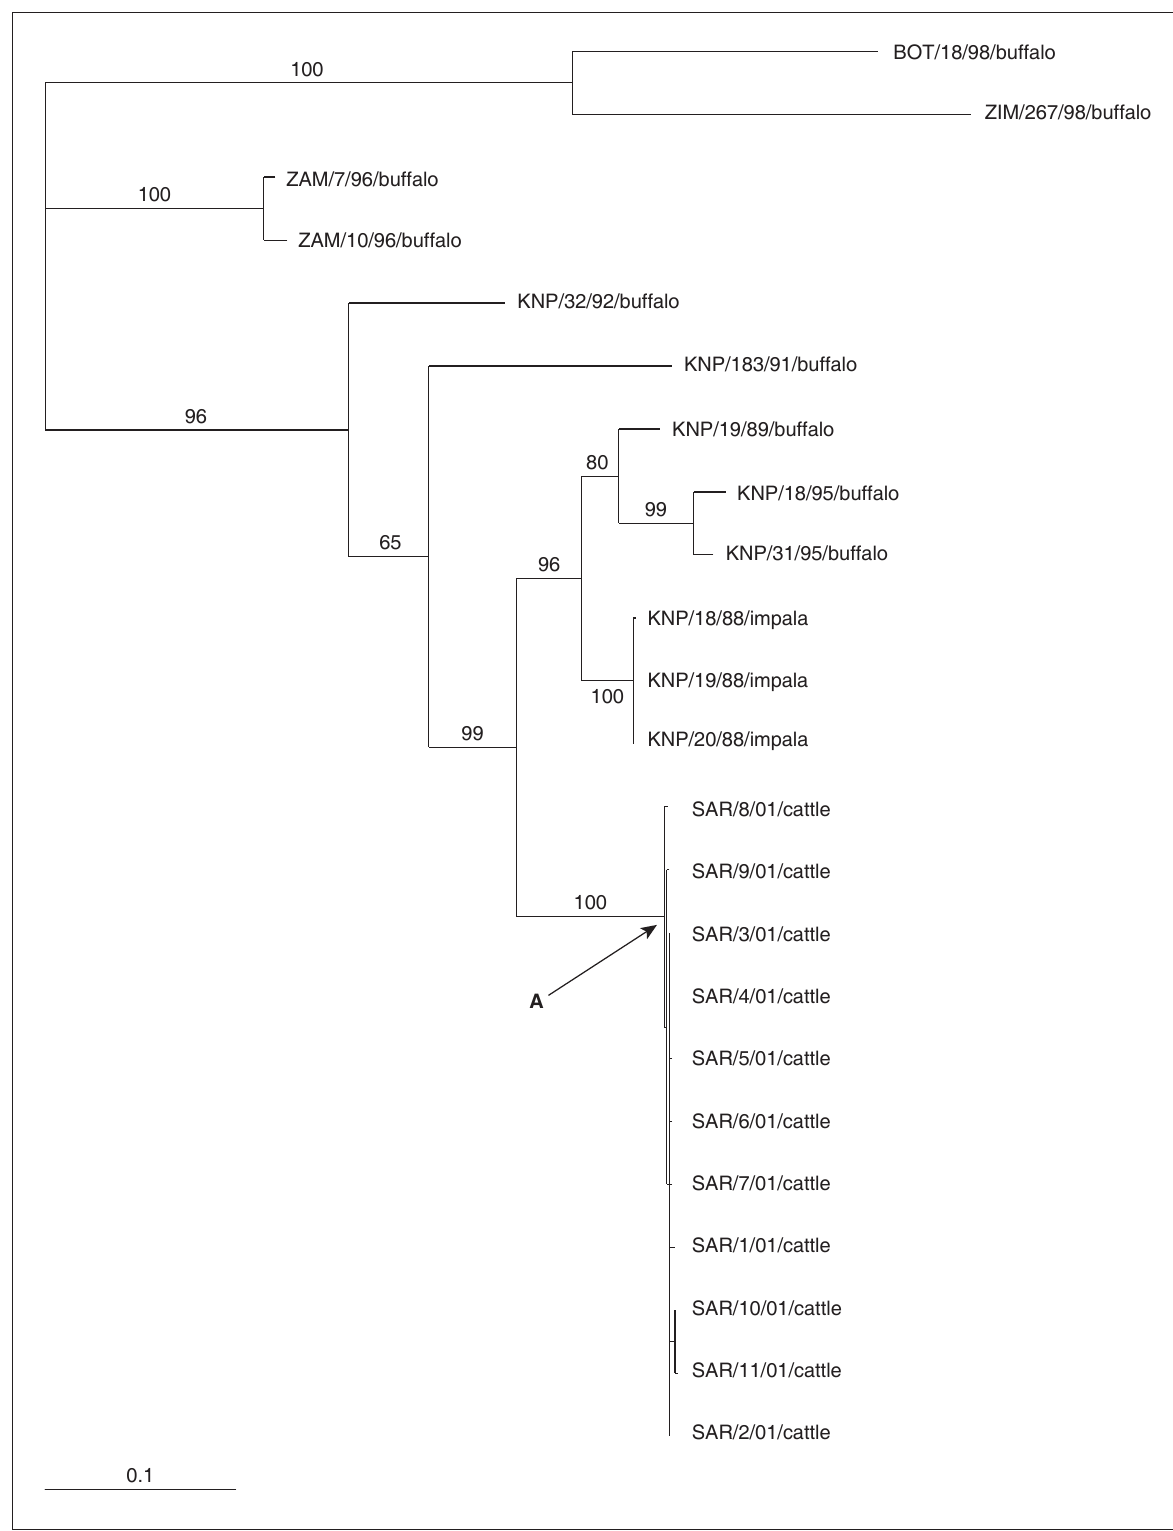
/ d ratio was fitted n s